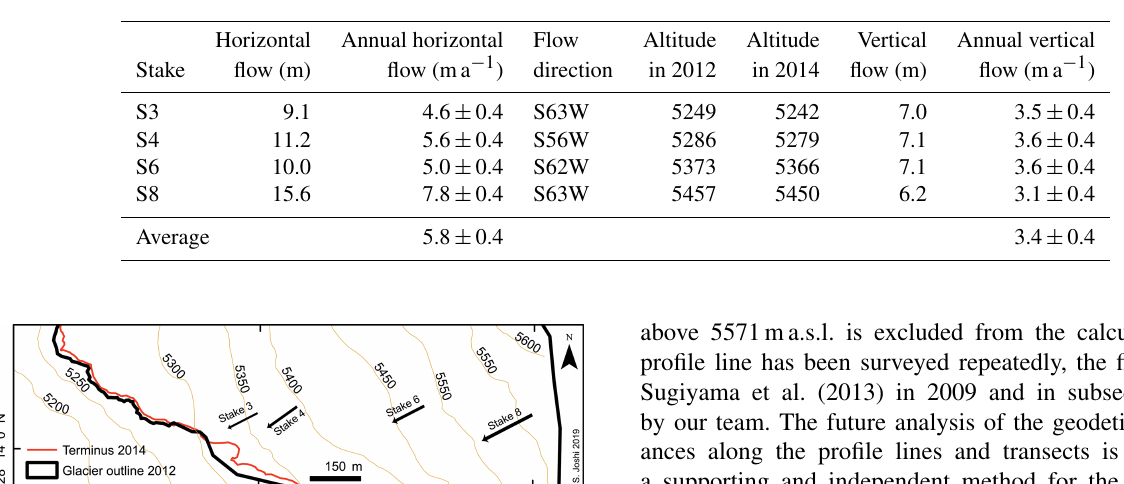
Table 5. Glacier flow in metres and direction of Yala Glacier at the stakes S3, S4, S6 and S8 from 8 May 2012 to 5 May 2014.